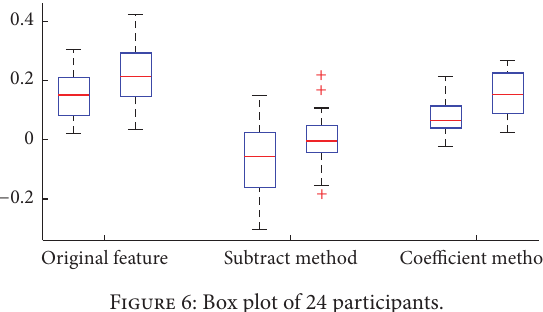
Figure 6: Box plot of 24 participants.